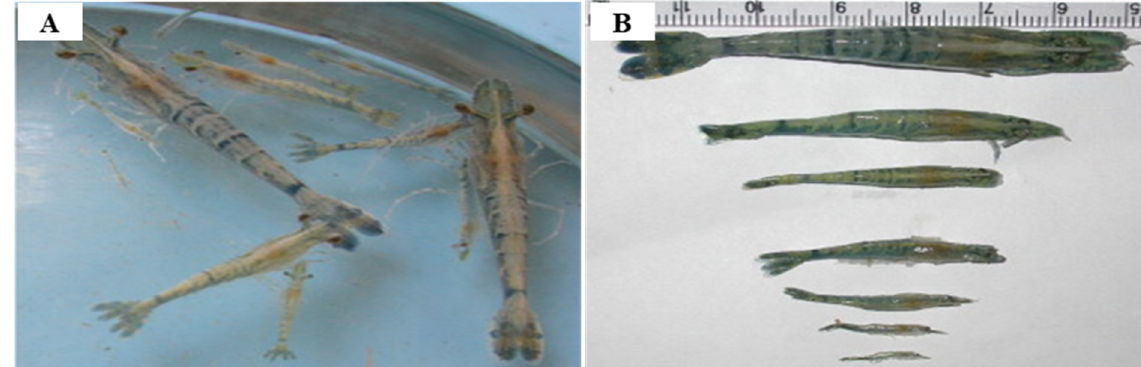
Figure 10. Size variations observed in 50-day-old Penaeus monodon with infectious hypodermal and hematopoietic necrosis virus (IHHNV) ( A , B ) (Reprinted from Aquaculture, Vol. 289 (3–4), Rai, P., Pradeep, B., Karunasagar, I., Karunasagar, I., Detection of viruses in Penaeus monodon from India showing signs of slow growth syndrome, p. 5, Copyright (2009), with permission from